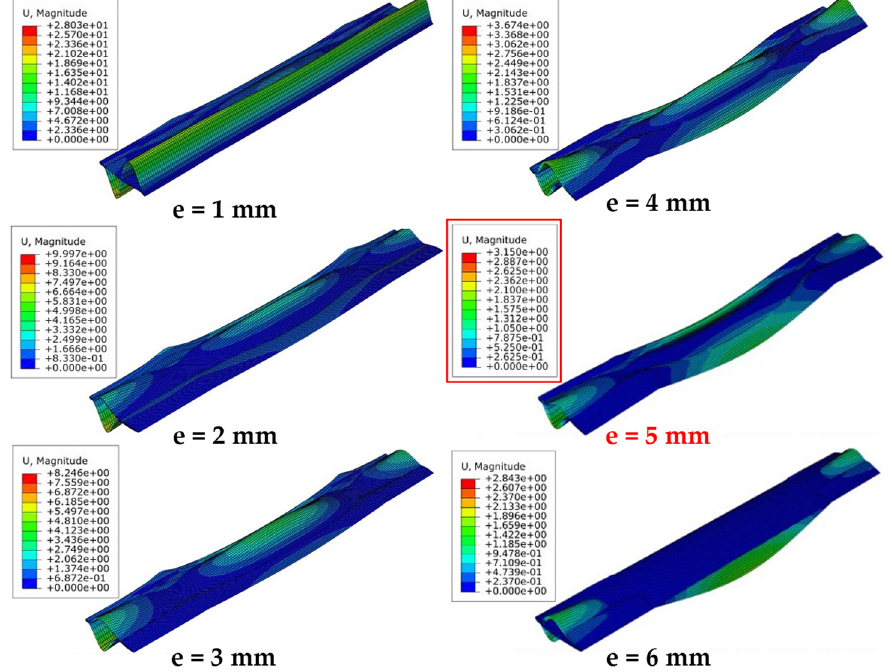
Figure 12. Displacement U for different thickness values of Aluminum 1 rotor blade after the application of extreme loads.